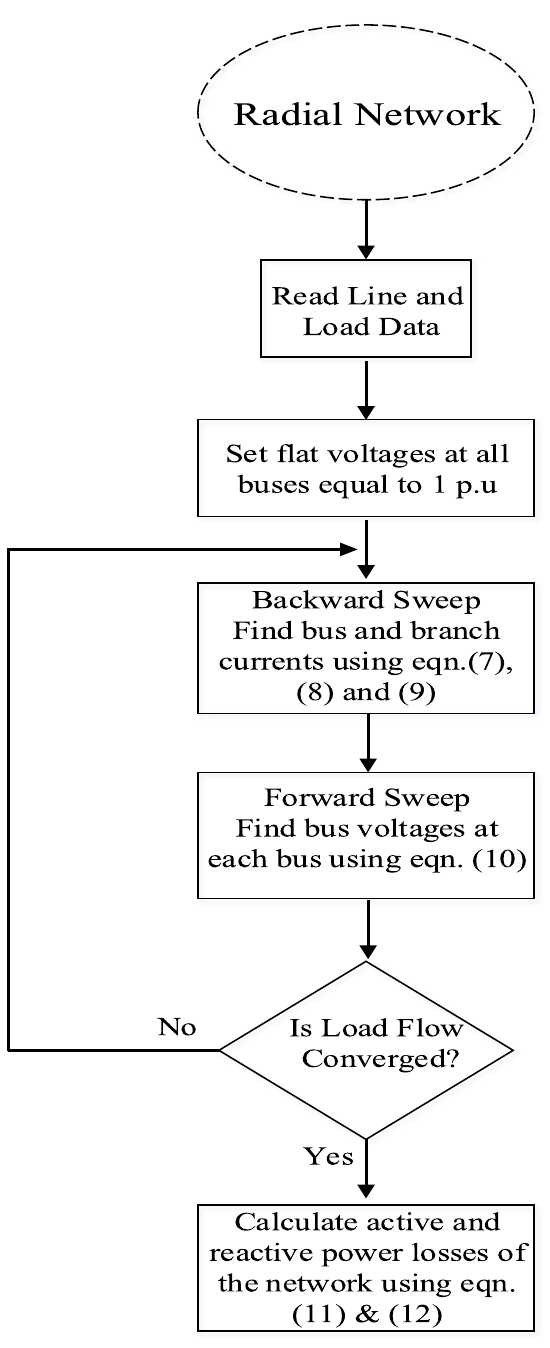
Fig. 7 Flow chart of Backward Forward Load Flow